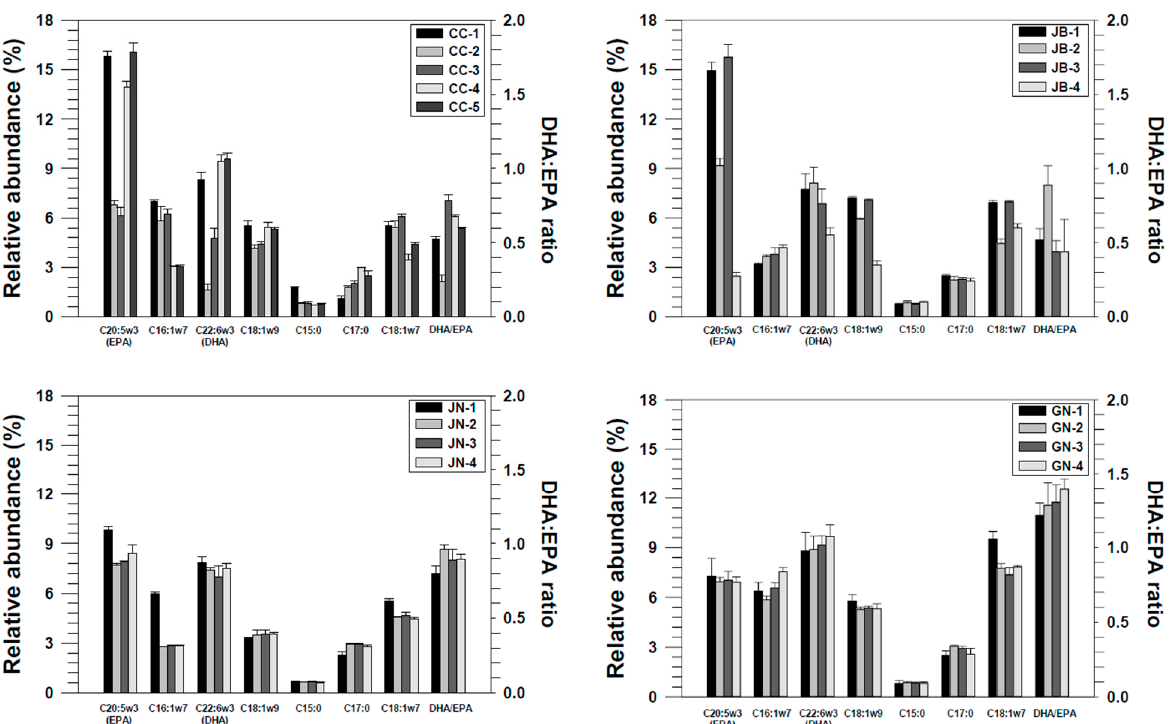
Figure 4. Relative abundance of biomarker fatty acids (diatom, flagellate, and bacteria) and the ratio of DHA to EPA in Manila clams from four different regions (Chungcheong (CC), Jeonbuk (JB), Jeonnam (JN), and Gyeongnam (GN)) of Korea for evaluating the source differences.